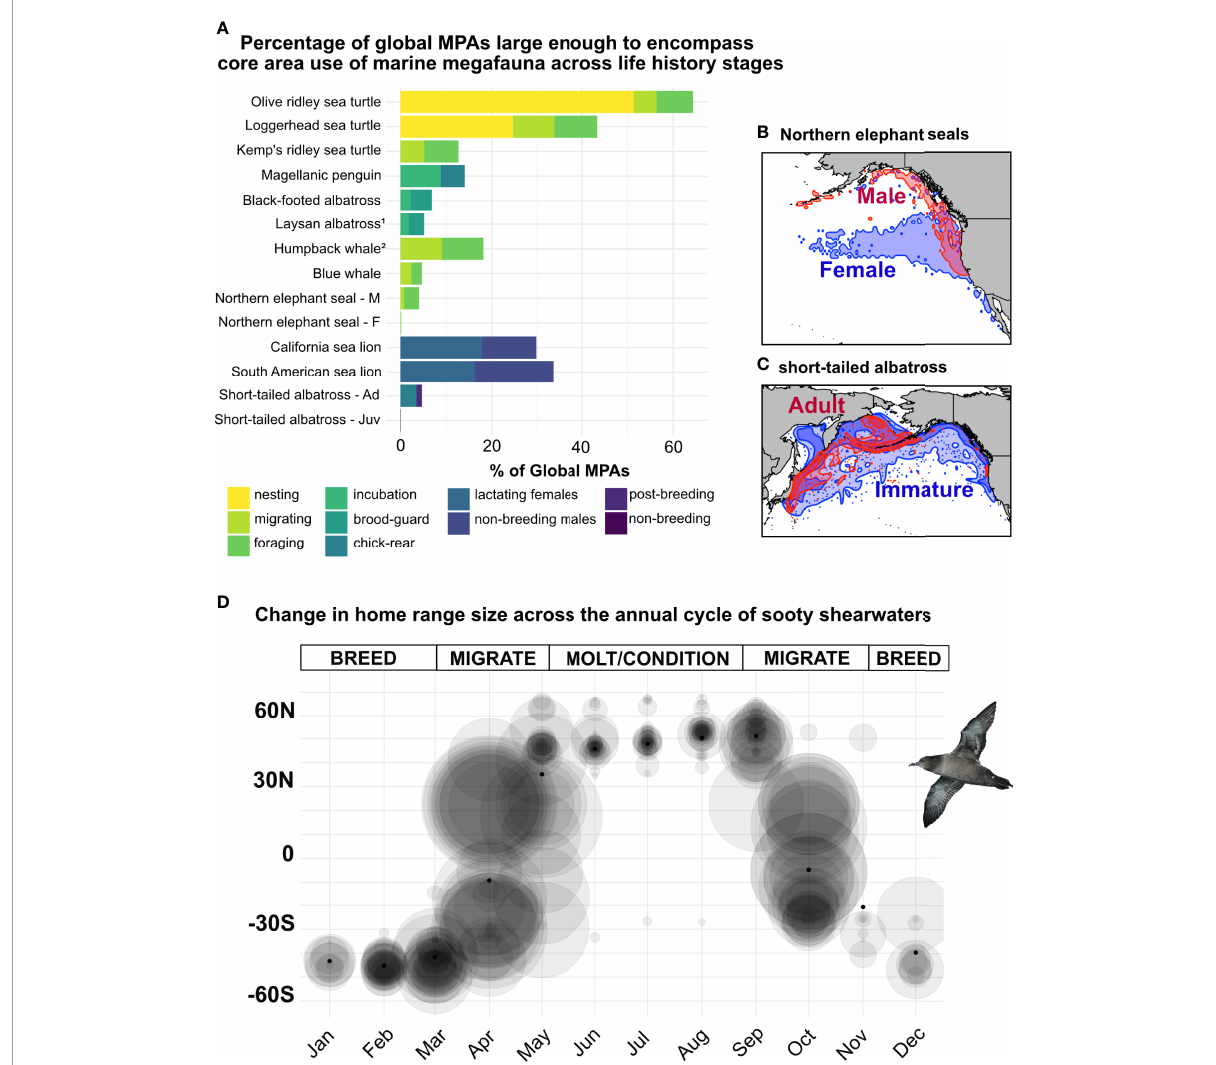
FIGURE 5 Tracking datasets from fifteen species demonstrate how the size distribution of current MPAs relates to the potential spatial protection of marine megafauna species under different sex, age, and seasonal contexts (panel A ). Male northern elephant seals strictly forage along the northeast perimeter of the North Pacific Ocean, along the continental shelf, while females primarily target the pelagic North Pacific Transition Zone, far offshore (panel B ). Immature short-tailed albatrosses are far more pelagic than their adult conspecifics, resulting in larger home range and core use areas (panel C ). The annual cycle of sooty shearwaters includes vast trans-equatorial migrations in which birds travel from breeding grounds in the high latitudes of the south Pacific to their foraging and molting grounds in high latitudes of the North Pacific in the boreal summer (panel D ) (Shaffer et al., 2006). Individual shearwater home ranges are plotted, by month, as a transparent grey circle whose radius was scaled to home range size; each individual home range circle was plotted monthly with their position on the y-axis displaying the average monthly latitude of that individual. Mean latitude of all shearwaters was overlaid on each month as a black dot. 1 Tagging Site, Tern Island; 2 Tagging Site, West Coast